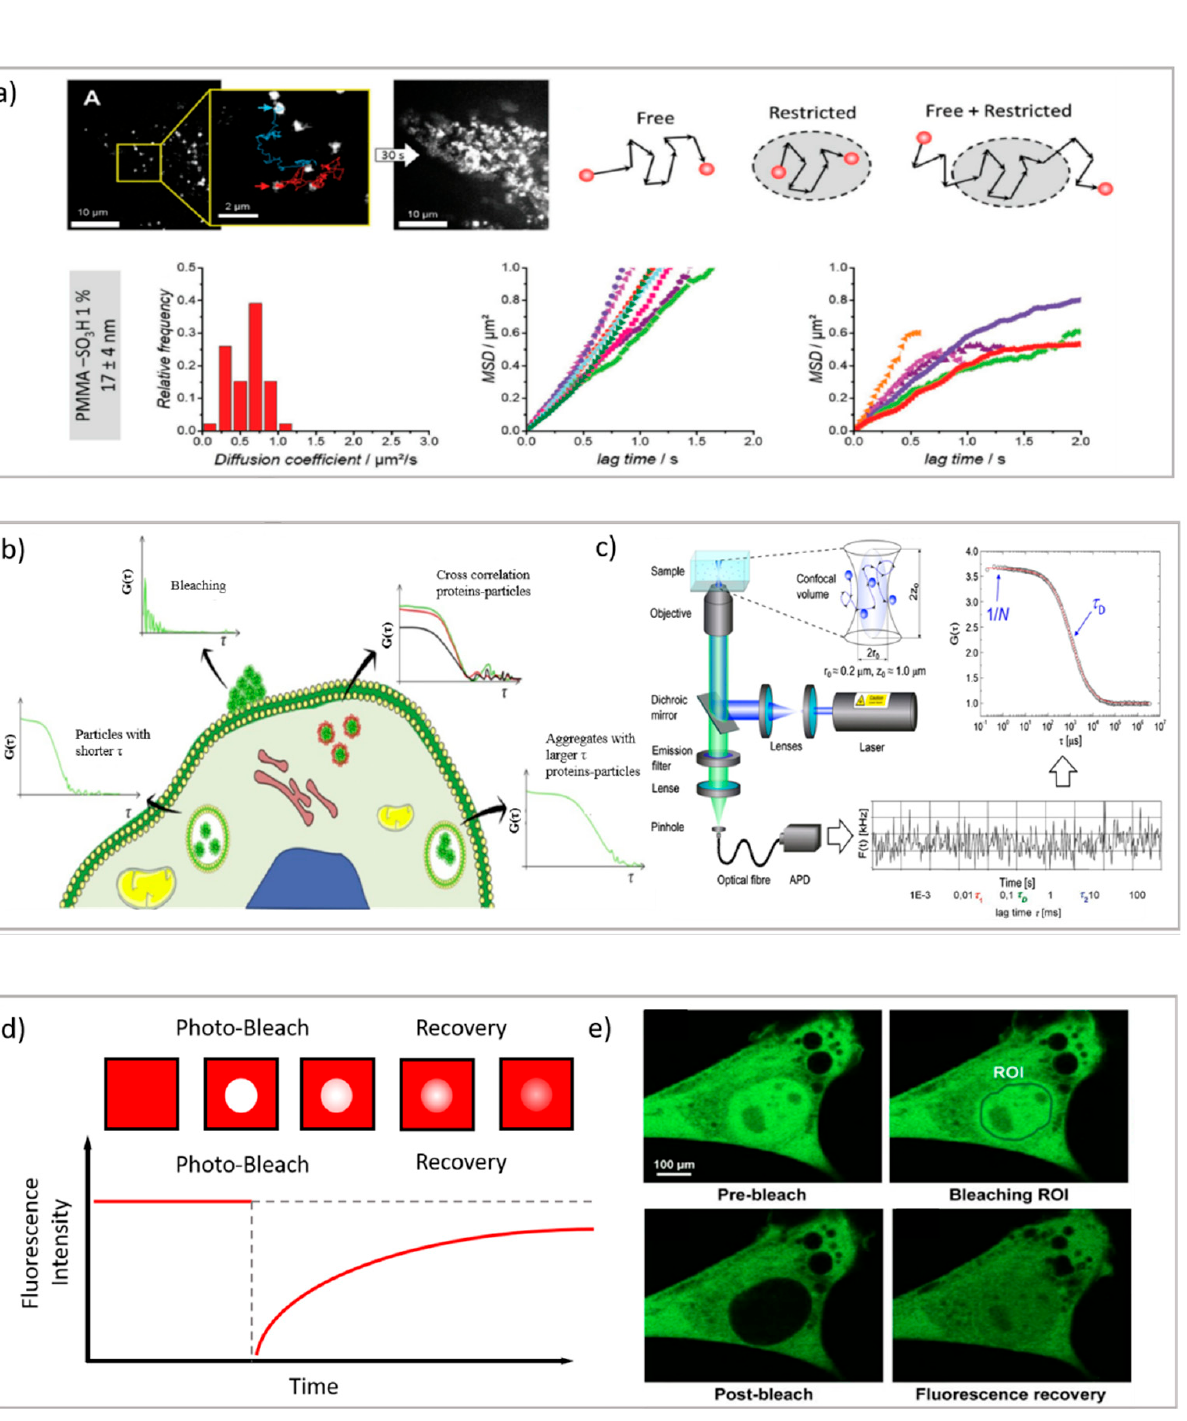
9 of 17 Figure 2. Top: schematic illustration of ( a ) TIRF microscope [66] and TIRF micrographs; ( b ) SLBs formed on planar silica with auto-fluorescent felodipine. Scale bar = 20 mm (adapted with permis- sion from [61]; copyright (2020), the authors; Angewandte Chemie published by Wiley-VCH GmbH); bottom: schematic illustration of ( c ) the LSFM microscope and tomography; ( d ) LSFM of large multicellular tumor spheroids (Scale bar 100 µm); readapted from [63] (copyright (2019), with permission from Elsevier). 3. Dynamics of Drug Delivery System As reviewed in the previous section, thanks to the advancements of fluorescence mi- croscopy, it is now possible to determine the localization of drug delivery with nanometric resolution. This undoubtedly represents an opportunity to understand the fate of DDSs in living organisms. Another opportunity offered by fluorescence microscopy and laser scanning confocal microscopy-related techniques is to determine not only the localization of nanosystems or drug delivery systems but also their dynamics. Techniques such as particle tracking (PT), fluorescence correlation spectroscopy (FCS), and fluorescence re- covery after photobleaching (FRAP), which basic principles are summarized in Figure 3, can be useful to thoroughly determine the behavior of the DDSs in vitro and in vivo. In particular, these techniques can be used to: (i) characterize the cellular uptake of DDSs (which is the internalization pathway; if the DDS is internalized by cells as a whole or in a disaggregated form); (ii) characterize the binding of the DDS to relevant biomolecules; (iii) characterize the motion of the DDS in bio-relevant fluids; and (iv) characterize the interaction of the DDS with biomembranes. In addition, these techniques have also been profitably exploited to characterize the DDS itself, thus providing additional relevant in- formation with respect to the most common physical chemistry techniques. In recent years, the diverse techniques have also taken advantage from the new advancements of